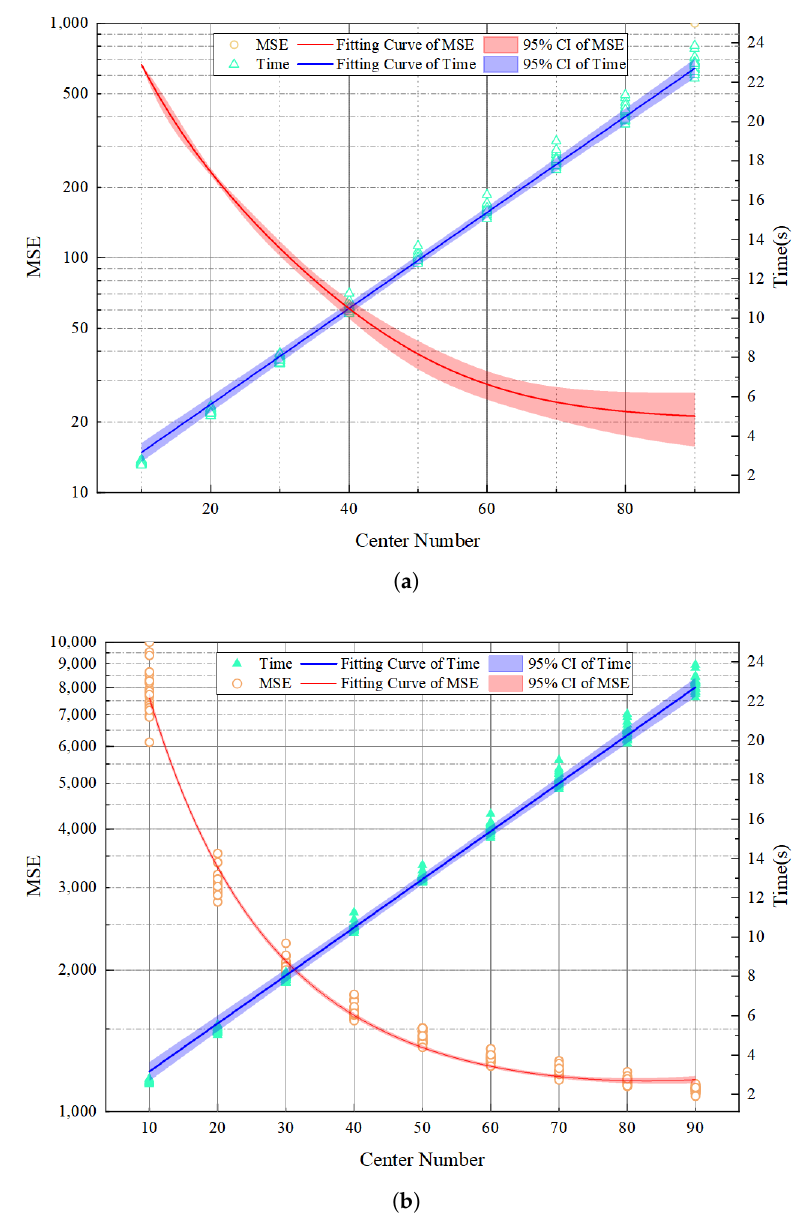
Figure 5. The trade-off between MSE and time on 10D ellipsoid and rastrigin. ( a ) Ellipsoid. ( b )